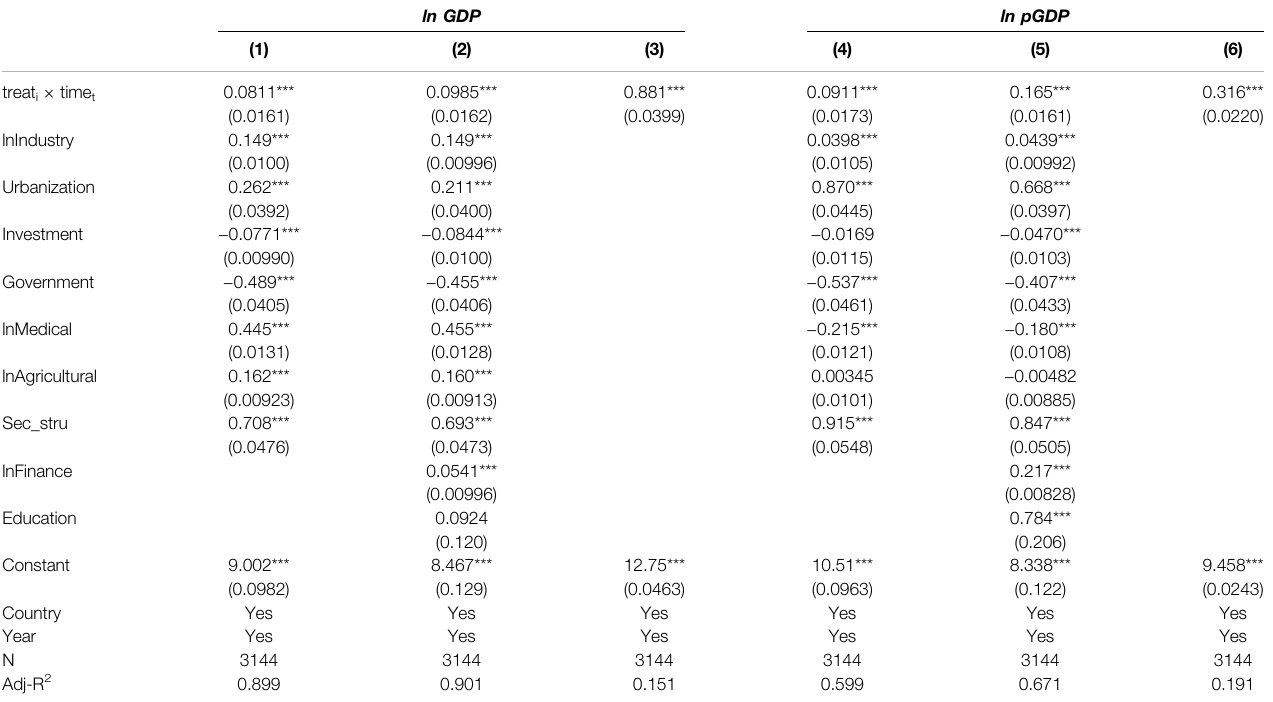
TABLE 3 | Benchmark regression